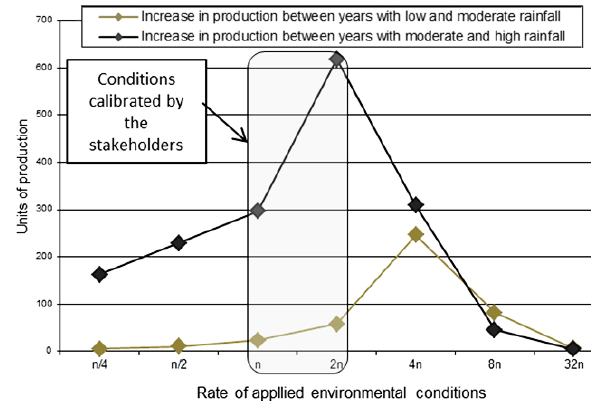
Fig. 7 . Impact of variation in rainfall on different types of production in the computerized version of the game, according to the scarcity of natural resources. The graph shows the results of a series of computer simulations in which natural resources in the landscape vary (see x axis: rate of available resources). The y axis shows the rate of production depending on the yearly rainfall: a higher curve means a greater effect of rainier years on productivity.